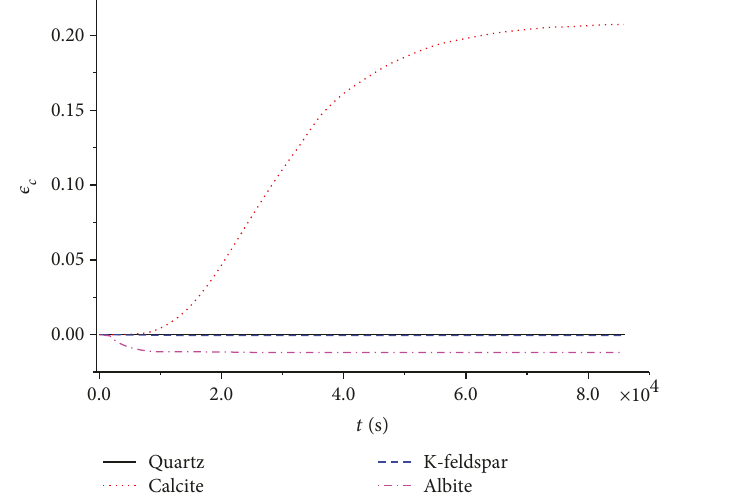
Figure 17: The evolution of the pH with time.